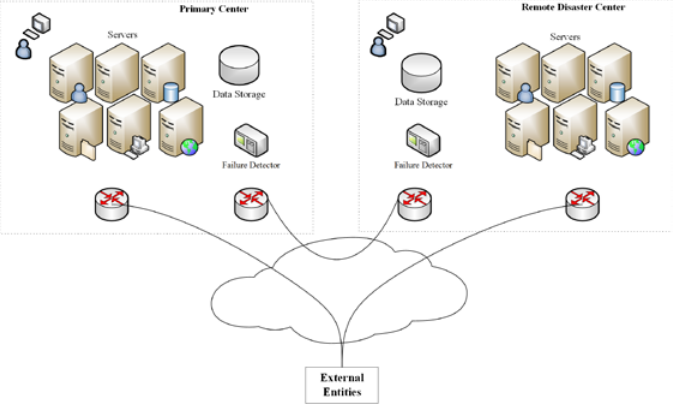
Fig. 1. Disaster recovery system